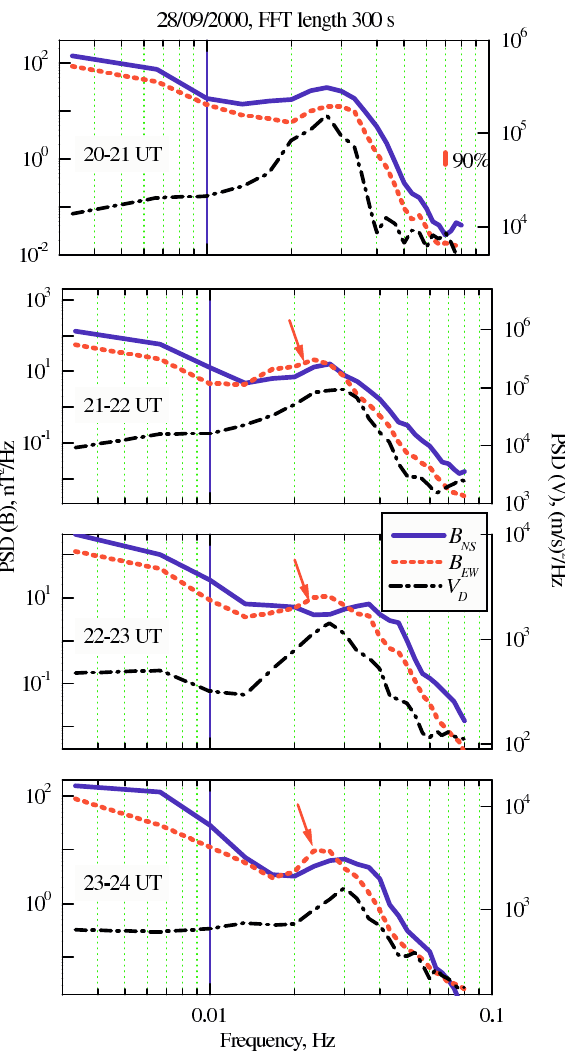
Fig. 6. Ionospheric (black) and ground (blue and red) power spec- tra obtained with frequency resolution δf =3.33mHz (FFT-length 300s). Red arrows show areas where PSD in the EW components exceeds that in the NS component, which we interpret as a signature of a poloidal FLR harmonic. The red vertical bar on the right side of the top panel shows 90% confidence interval for spectral density in the magnetometer